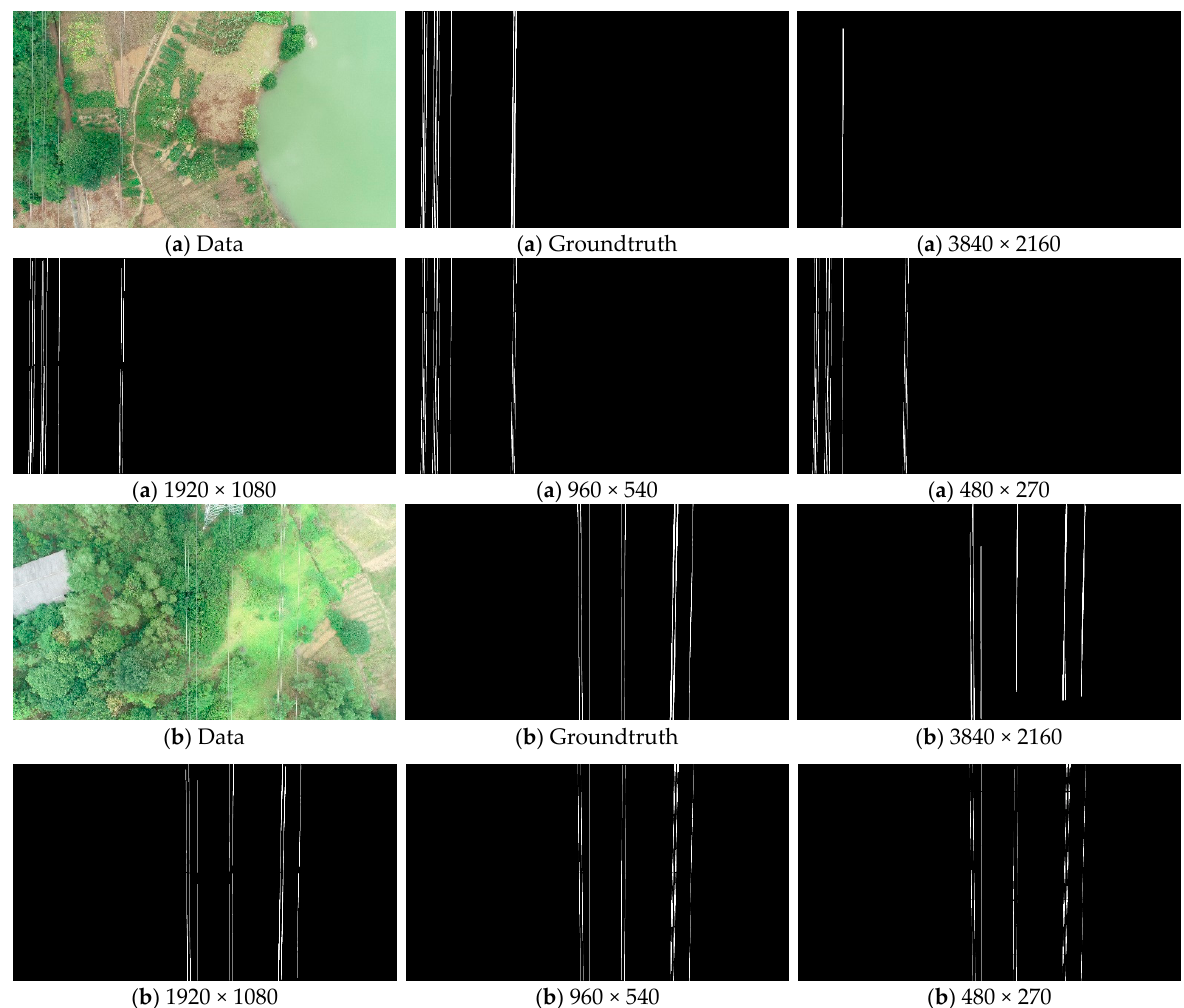
Figure 11. Extraction results of Mask RCNN at different sizes. There are ( a , b ) two groups of extraction results with different image backgrounds, each group has six images, which are the input image (Data), the truth image (Groundtruth), and the extraction results in four sizes (480 × 270, 960 × 540, 1920 × 1080, and 3840 × 2160).